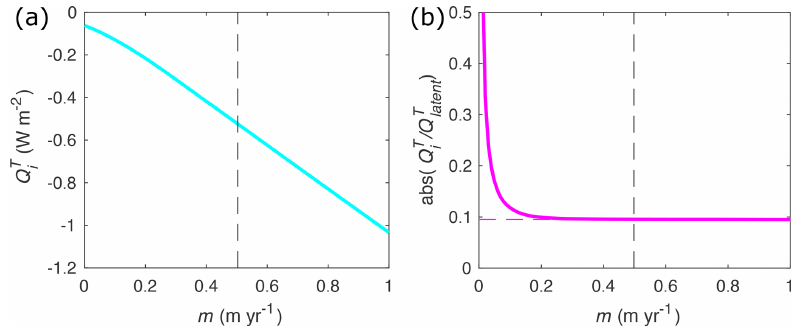
Figure B3. (a) Heat flux into the ice ( Q T ) as a function of melt rate m from a one-dimensional advection–diffusion model for a 607m thick i ice shelf with a − 20 ◦ C surface and − 2.1 ◦ C basal temperature. (b) Ratio of Q T to latent heat flux due to melting Q T as function of m . i latent The vertical dashed lines correspond to the annual average melt rate of 0.51myr − 1